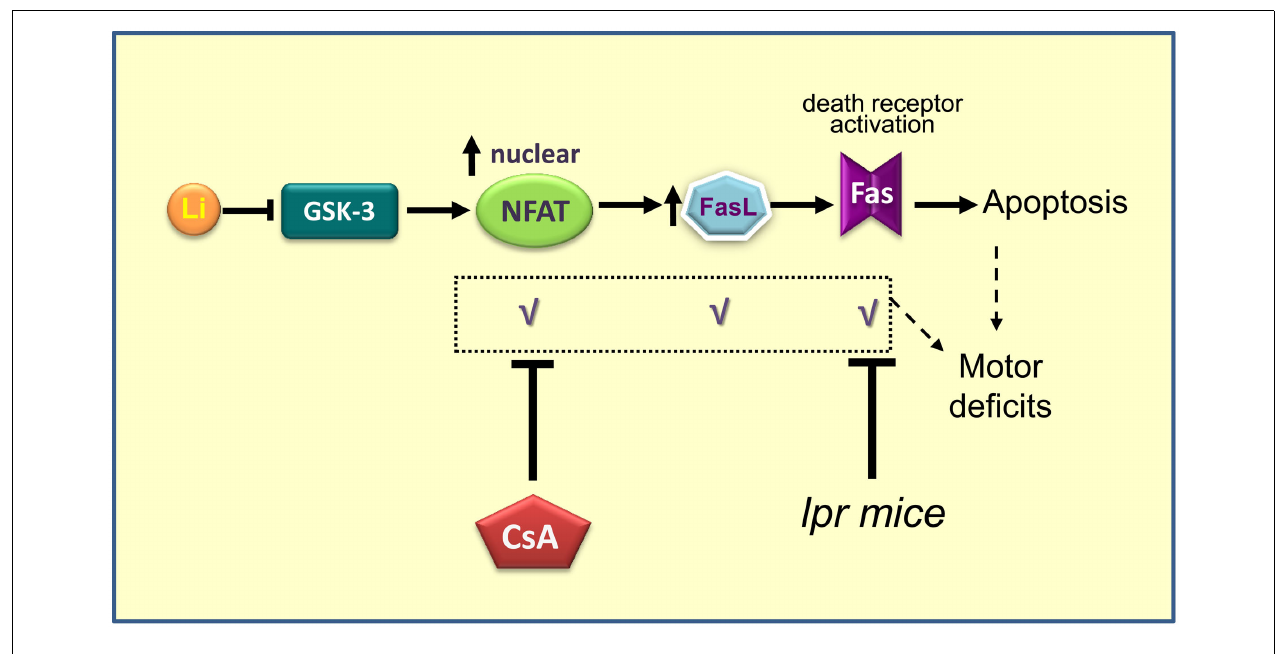
outside the cell binds to Fas receptor present in the membrane of the same cell or cells nearby, which triggers death by apoptosis.When NFAT/Fas signaling is blocked by co-administration of Cyclosporin A or when lithium is administered to Fas-deficient mice ( lpr ) motor deficits and apoptosis are